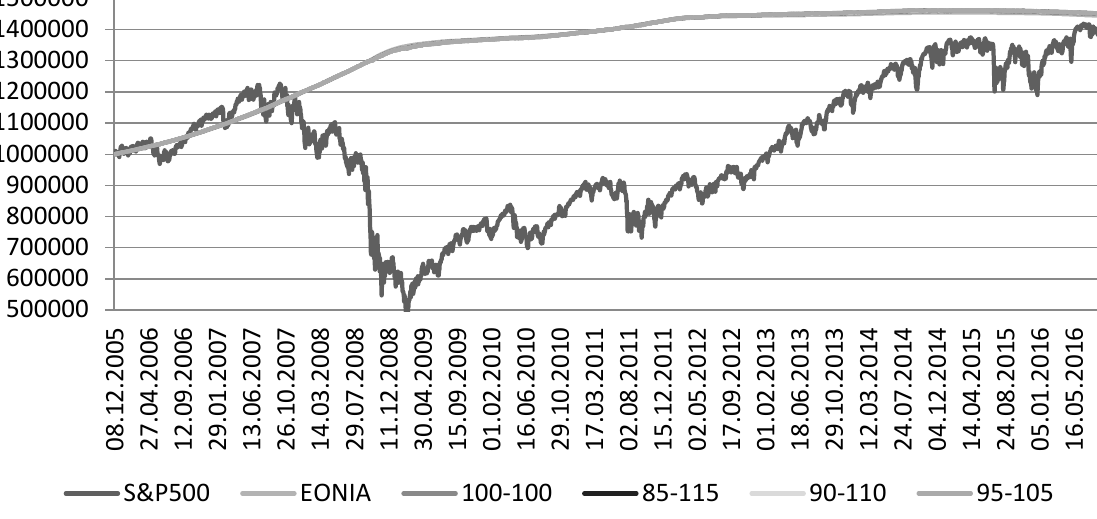
Figure 5. Evolution in the value of the investments based on 6M